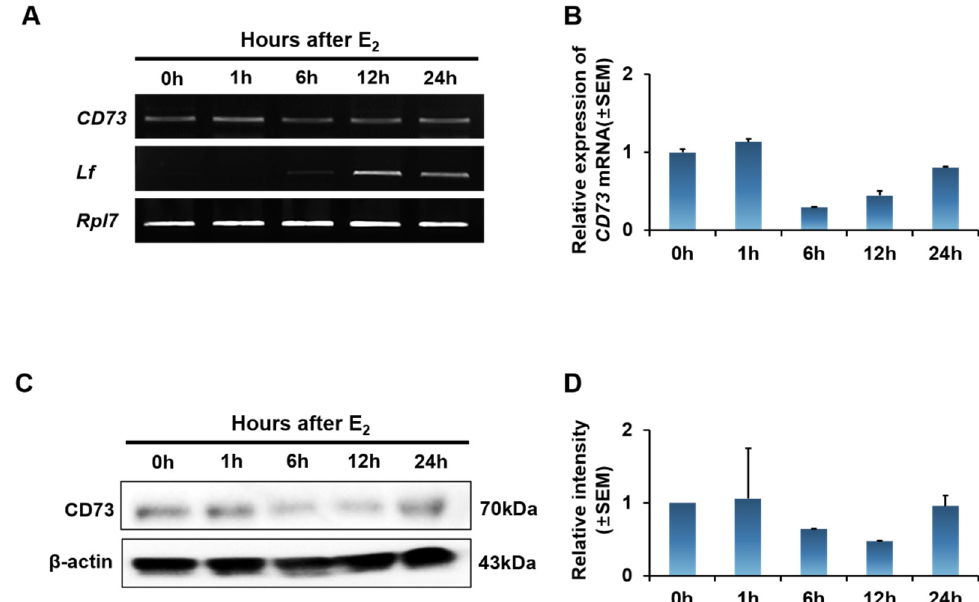
Figure 3. Estrogen effect in CD73 expression in ovariectomized (OVX) model. ( A ) RT-PCR analysis of CD73 mRNA in the uterus of the OVX mice after E 2 treatment for 0, 1, 6, 12, and 24 h (each group n = 4). Lactoferrin ( Lf ) gene was used to confirm the response of estrogen after ovariectomy. Ribosomal protein L7 ( Rpl7 ) gene was used as an internal control. ( B ) Quantitative RT-PCR shows the relative fold change of CD73 expression after estrogen treatment. The relative expression value was based on the value at 0 h after E 2 treatment. ( C ) Expression of CD73 was analyzed by Western blot analysis in the uterus of the OVX mice after E 2 treatment for 0, 1, 6, 12, and 24 h (each group n = 4). β-actin was used as an internal control. ( D ) Relative level of CD73 protein intensity in uterus of OVX mice after E 2 treatment. The relative expression value was based on the value at 0 h after E 2 treatment. Data are presented as the mean intensity ± SEM.